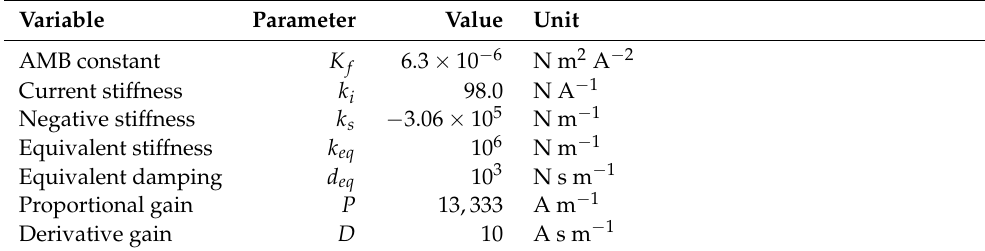
Figure 4. Relationship between AMBs stiffness and PID proportional gain, showing that a minimum P of 3000 A m − 1 gain is necessary to overcome the negative stiffness. Table 2. AMB control